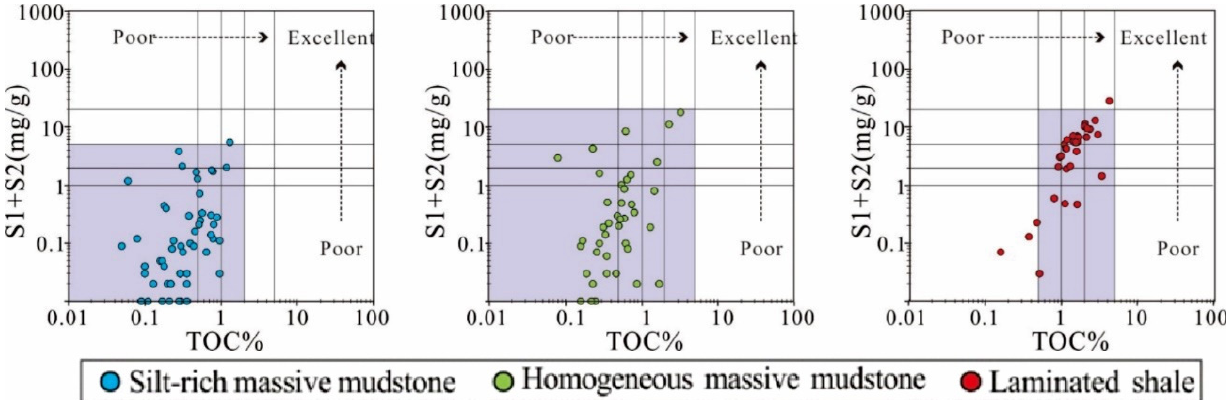
Figure 7. The hydrocarbon generation capacity of the three lithofacies (the circles stand for the samples of each lithofacies).